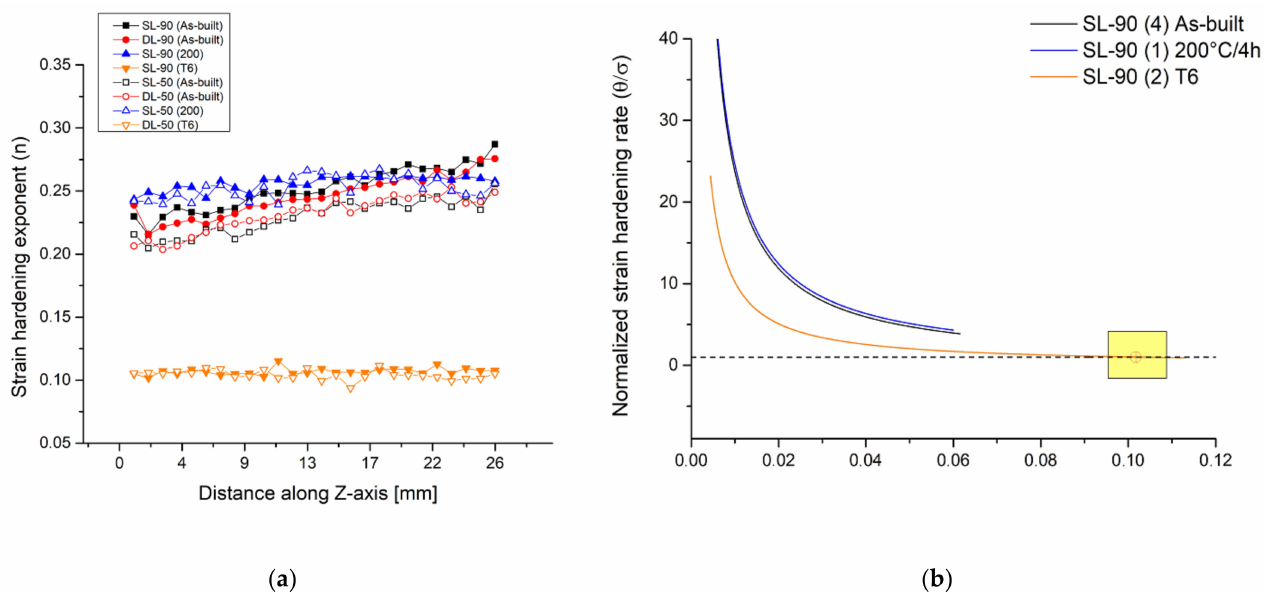
Figure 8. ( a ) Strain hardening values of as-built and heat-treated 90-samples and 50-samples in function of the distance from the build platform. ( b ) Normalized strain hardening rate samples. The black dashed line indicates the points that satisfy the Consid è re’s criterion, in other words, where the strain hardening rate and the true stress